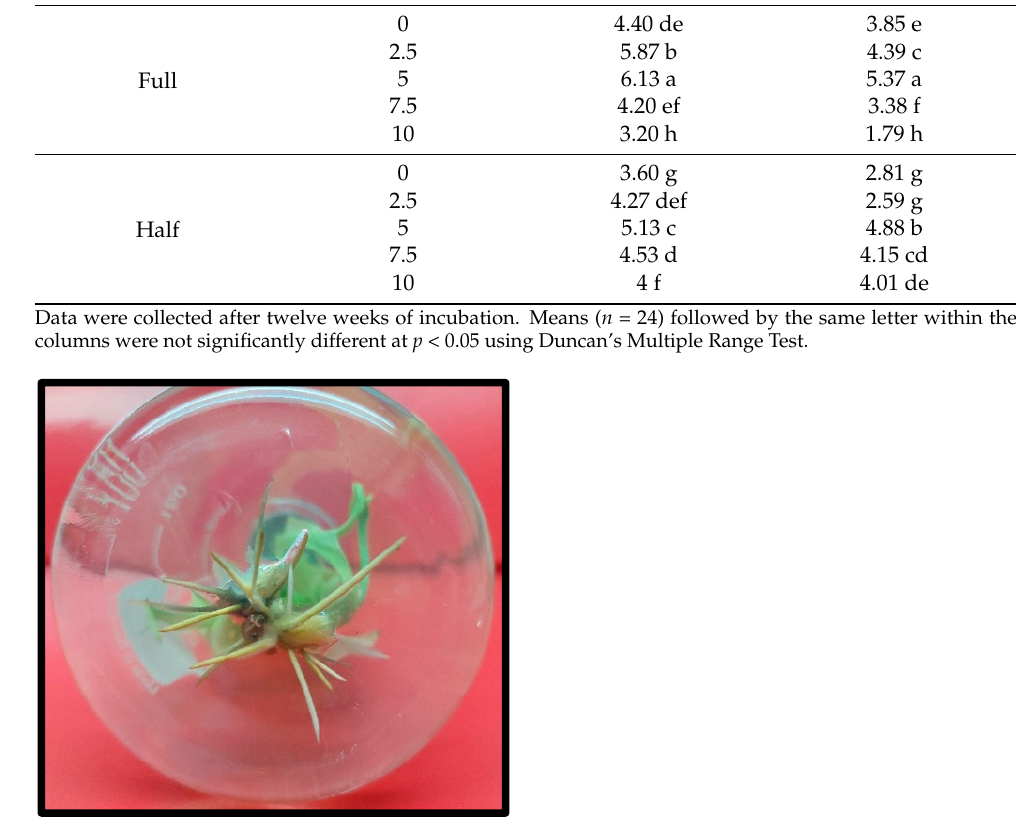
Figure 4. Regeneration of adventitious roots of C. caesia in the full strength of MSB5 medium supplemented with 5 μ M of IAA.